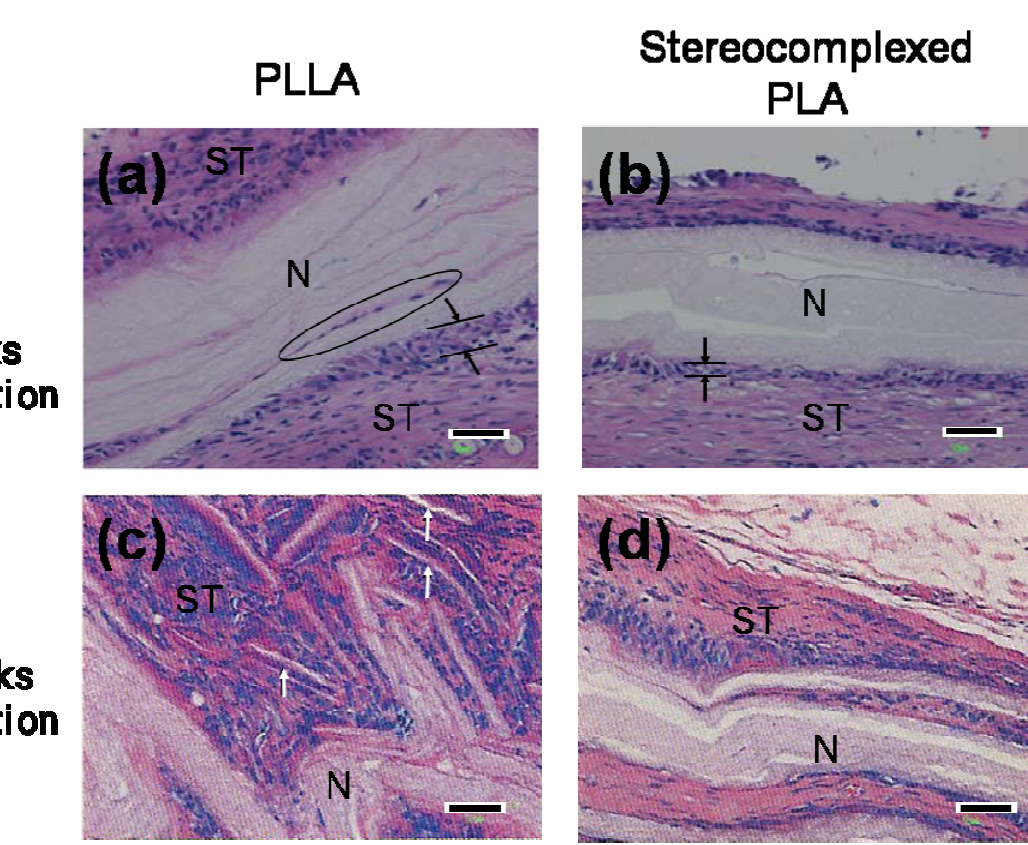
Figure 11. Phase contrast images of hematoxylin-eosin stained ultrathin sections of PLA nanofiber scaffolds after in vivo degradation for 4 to 12 weeks. N: Nanofiber scaffold. ST: Surrounding tissues. Scale bars = 50 μ m